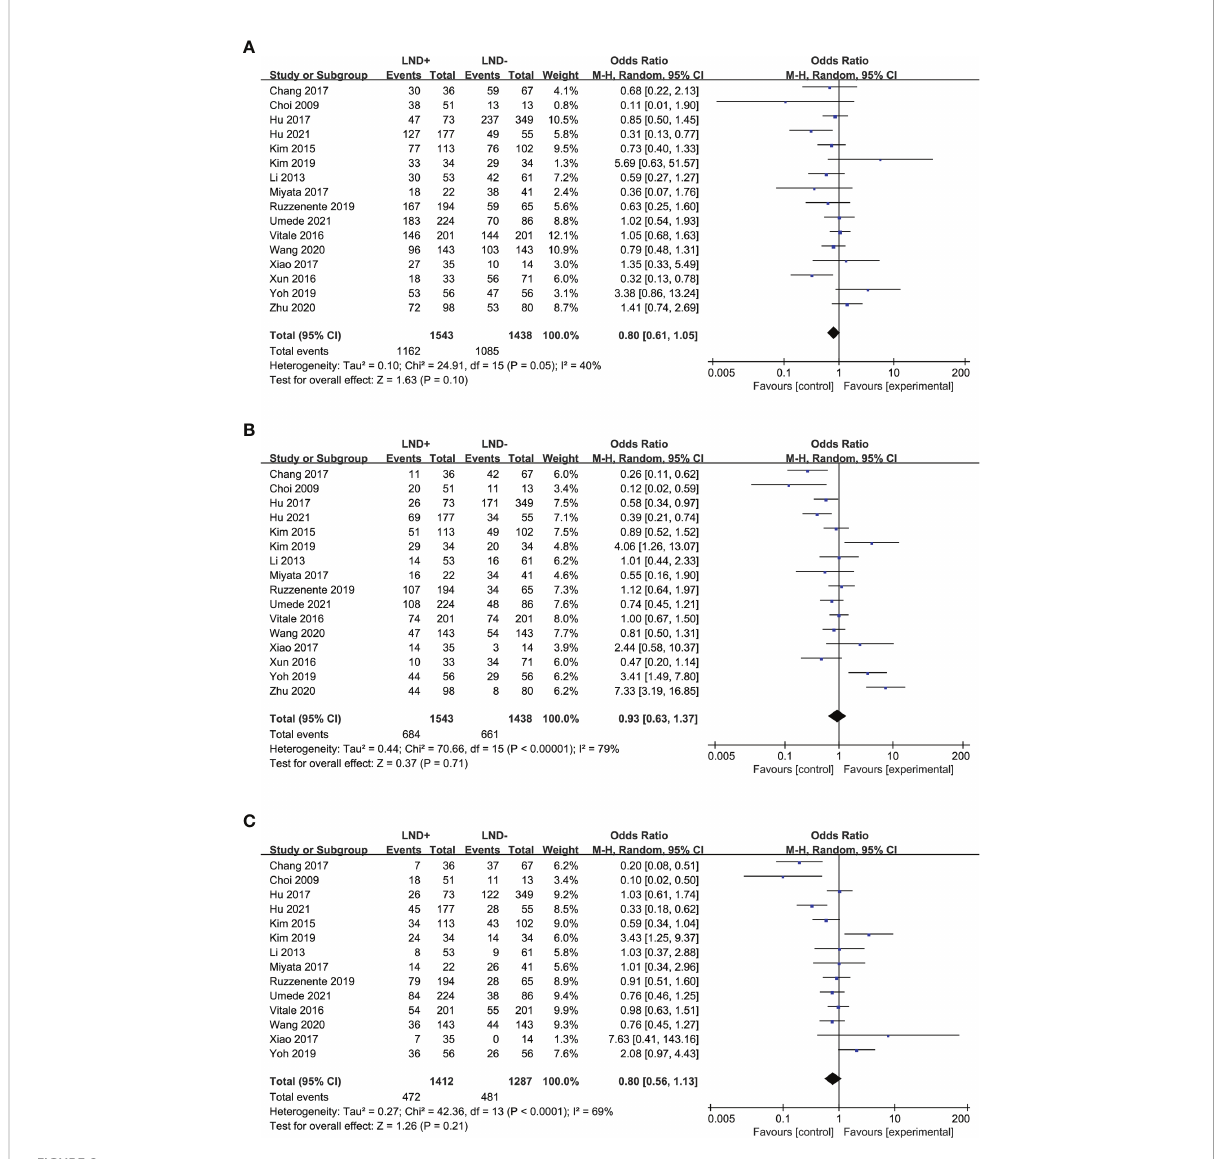
FIGURE 2 Forest plot comparing overall survival in LND+ and LND − groups. (A) 1-year OS; (B) 3-year OS; (C) 5-year